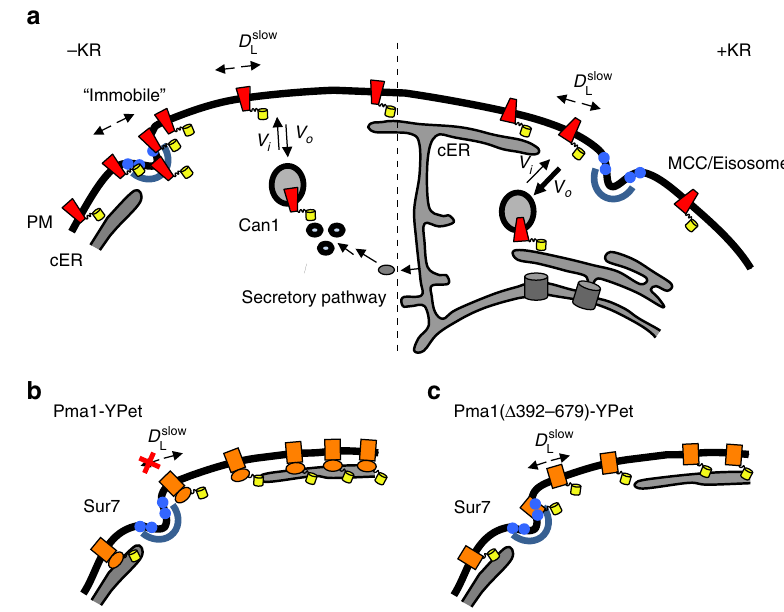
Fig. 6 Cartoon summarizing the main fi ndings on diffusion and localization of plasma membrane proteins. a The plasma membrane (PM), cortical ER (cER) and two MCC/eisosomes (Sur7 in the membrane and Pil1 scaffold) are shown. The scaffolding of the MCCs is shown as blue half circle (Pil1); the blue small circles depict Sur7 . D L , V i and V o refer to lateral diffusion and the rate of exo- and endocytosis, respectively. Left: in the absence of substrate ( − KR): a fraction of Can1 (red) accumulates in (near) the MCC/eisosomes and has an apparent D L < 10 − 5 μ m 2 /s, here indicated as “ immobile ” . The yellow cylinder depicts the fl uorescent proteins fused to the transporters. The total concentration of Can1 is stable as delivery to ( V i ) and removal from ( V o ) the membrane are similar. Right: in the presence of substrate (+KR): Can1 takes a different conformation and dissociates from the MCC/eisosome and diffuses out. Next, Can1 is ubiquitinated and rapidly removed from the membrane ( V o > V i ; indicated by thickness of arrow). b Large cytosolic domains exclude proteins from entering MCC/eisosomes, as shown for Pma1-YPet; c removal of the cytoplasmic domain enables (Pma1( Δ 392-679)-YPet) to enter the